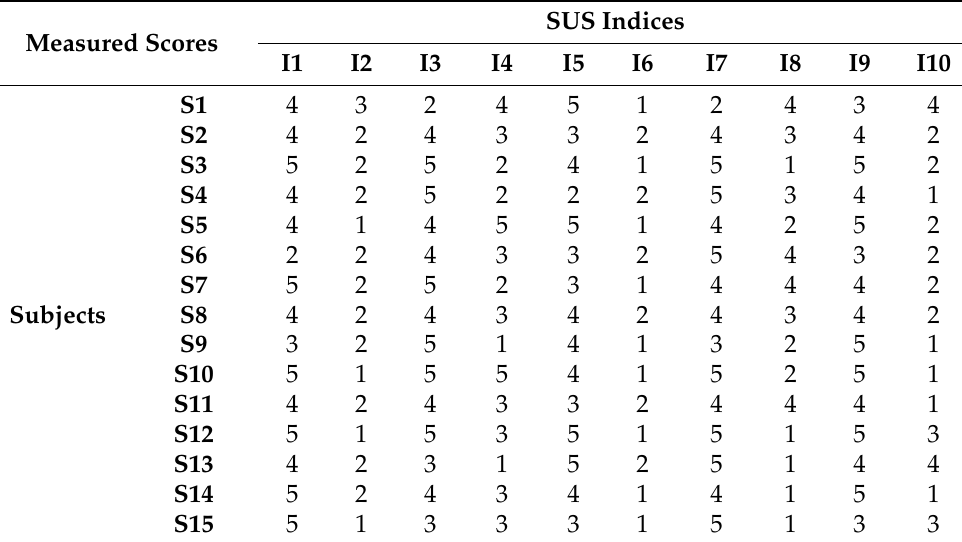
Table 5. Usability test subject-wise selection for SUS